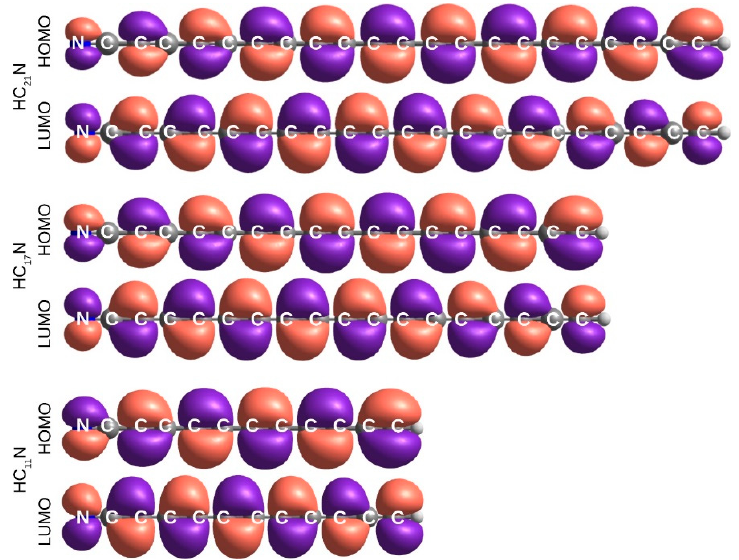
Figure 8. HOMO and LUMO molecular orbitals of select HC 2 n +1 N molecules (B972/aug-cc-pVTZ).